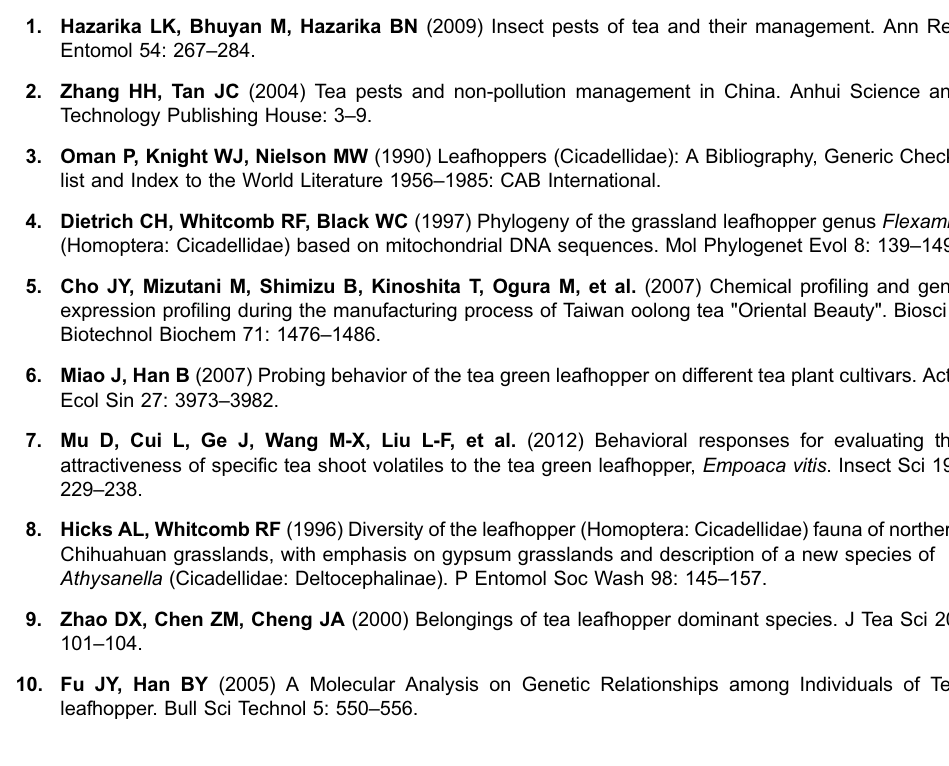
S2 Figure. The BI phylogenetic tree for 16sRNA of eleven leafhopper populations from Mainland China, Taiwan and Japan. S3 Figure. The BI phylogenetic tree for combined sequences of eleven leafhopper populations from Mainland China, Taiwan and Japan.